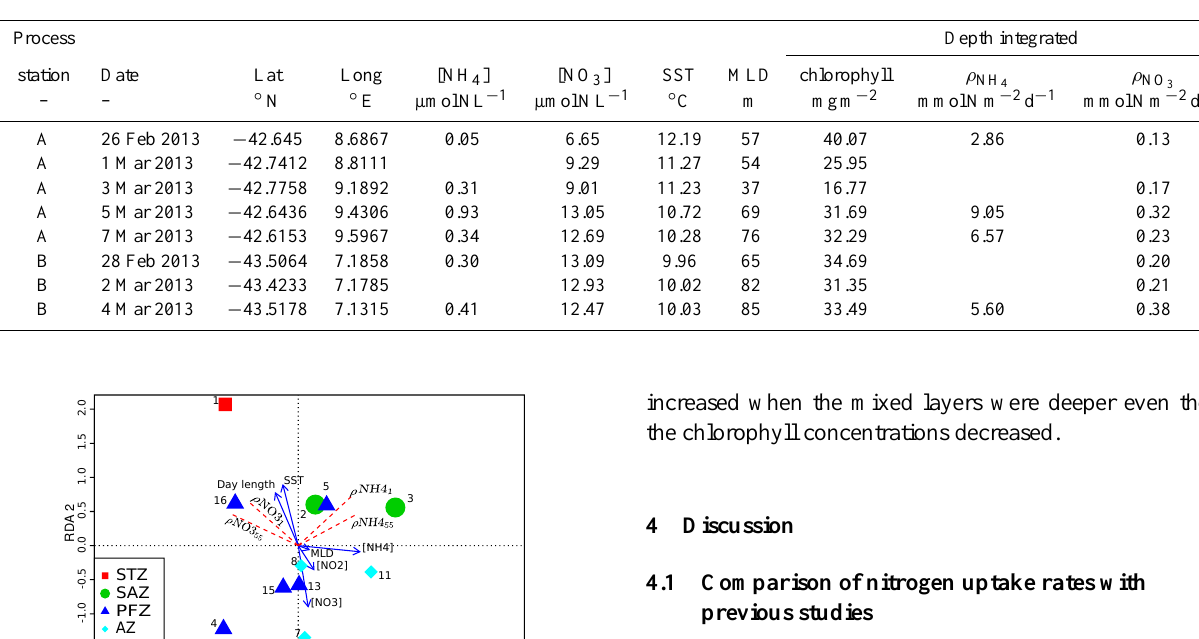
Table 2. Summer depth-integrated ρ NH